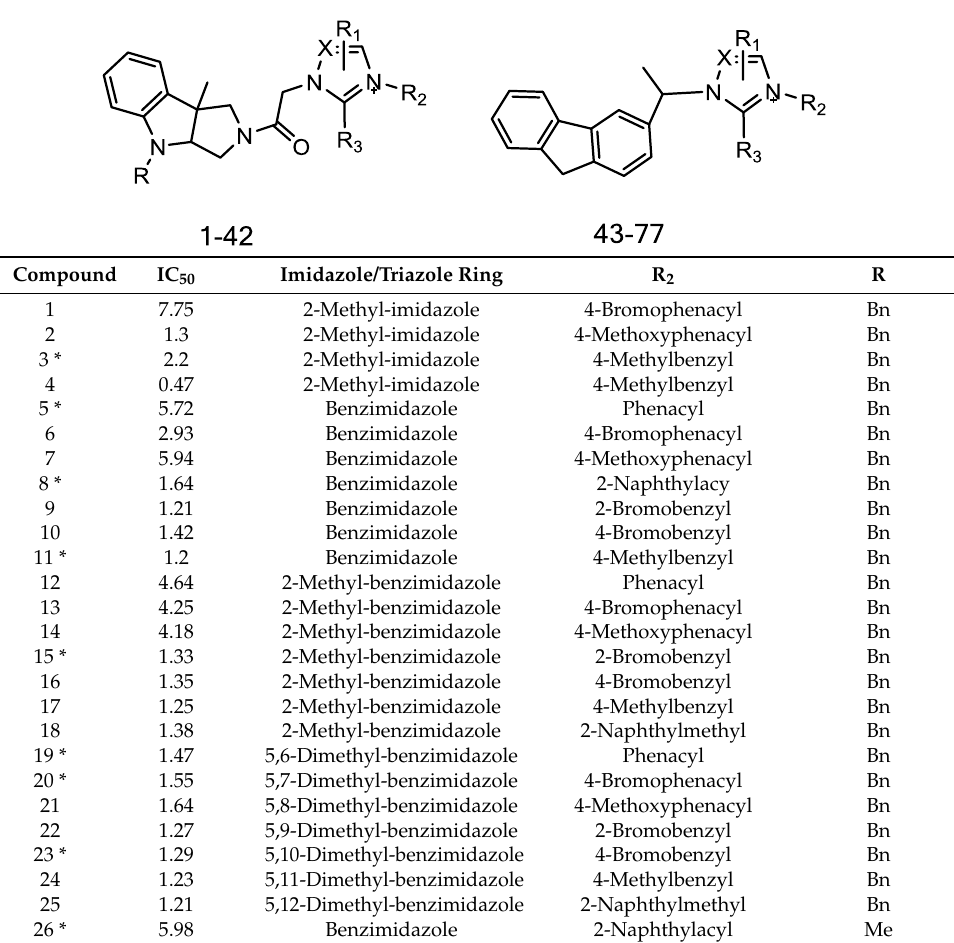
Table 4. The structure of the 77 imidazolium salt derivatives with the IC 50